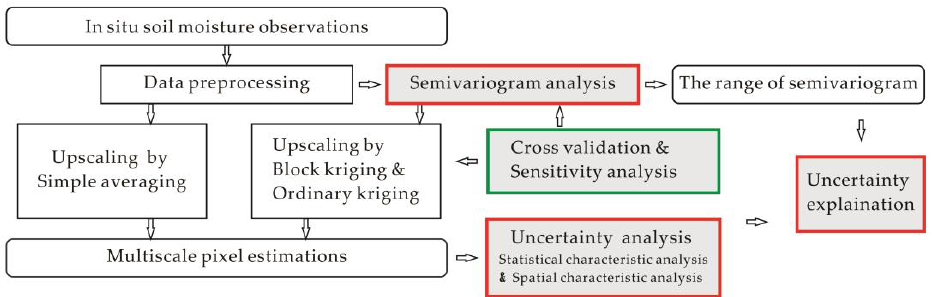
Figure 3. The technical flow chart for methodologies in this paper.